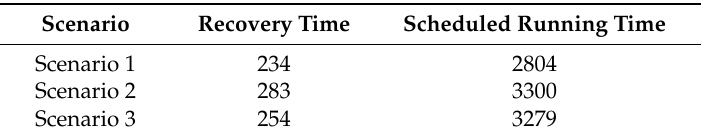
Table 6. Recovery time and scheduled running time. Unit: s.